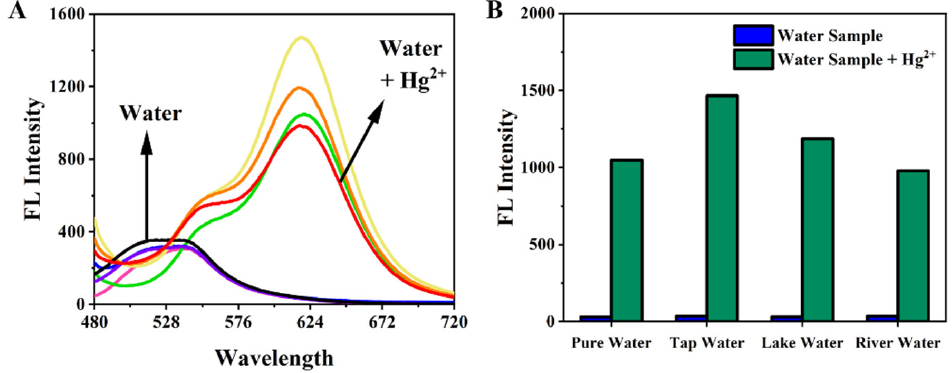
Figure 12. ( A ) 1 H NMR Spectrum of BNEA was measured in DMSO-d6, ( B ) 1 H NMR Spectrum of BNAE and Hg 2+ were measured in a mixed solvent (V DMSO-d6 :V CD4O = 1:1).